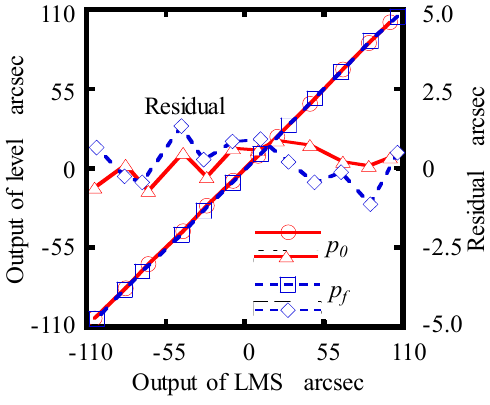
Figure 9. Calibration results of θ z .